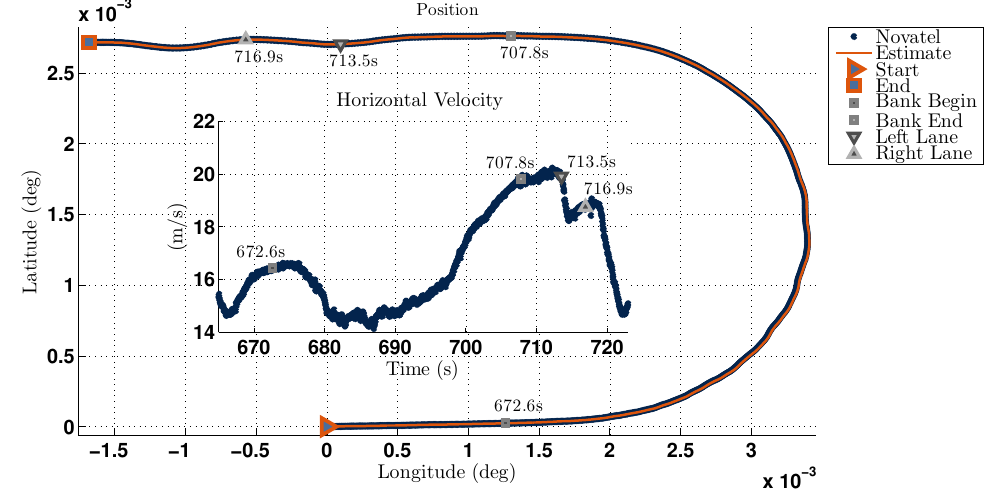
Figure 18. Coupled EKF on the NCAT oval track roll excitation position and velocity.